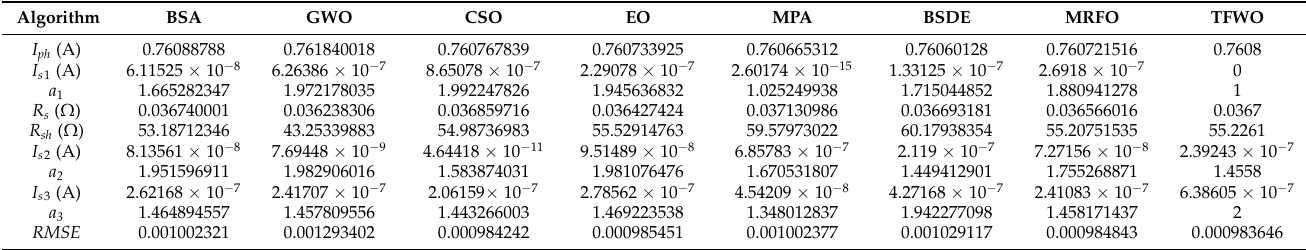
Table 7. The parameters extracted for R.T.C. France